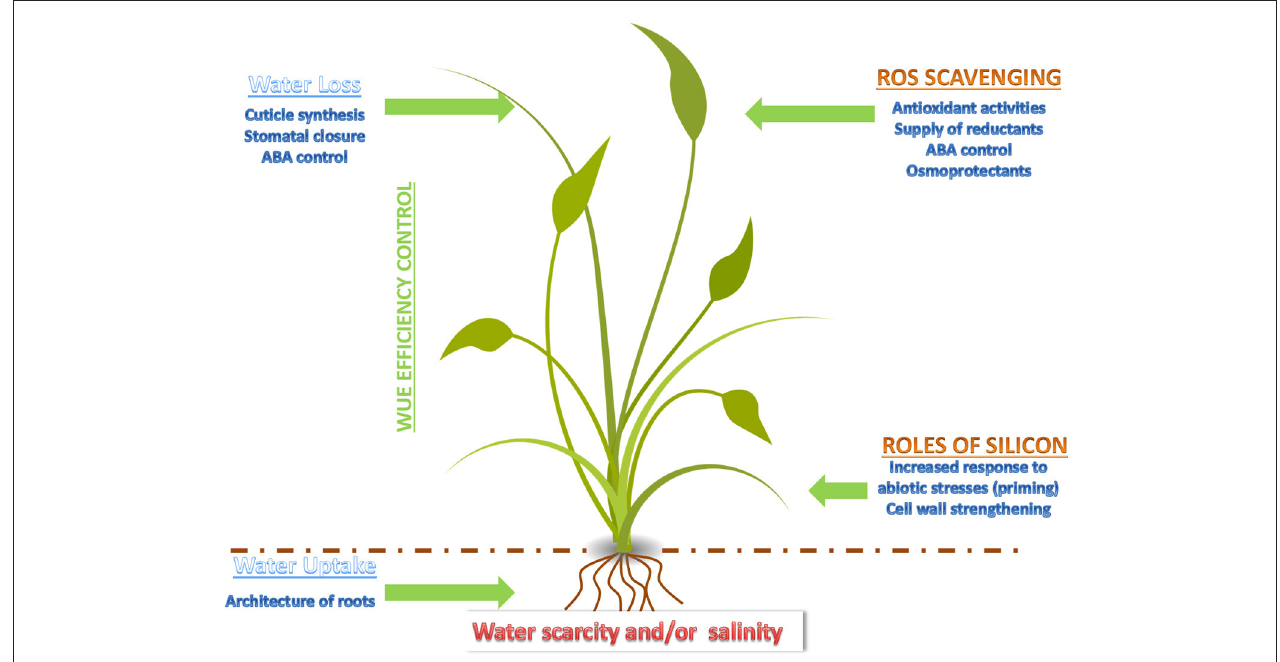
FIGURE 1 | Cartoon depicting the major events and factors affecting drought and salt stress response in a monocot.